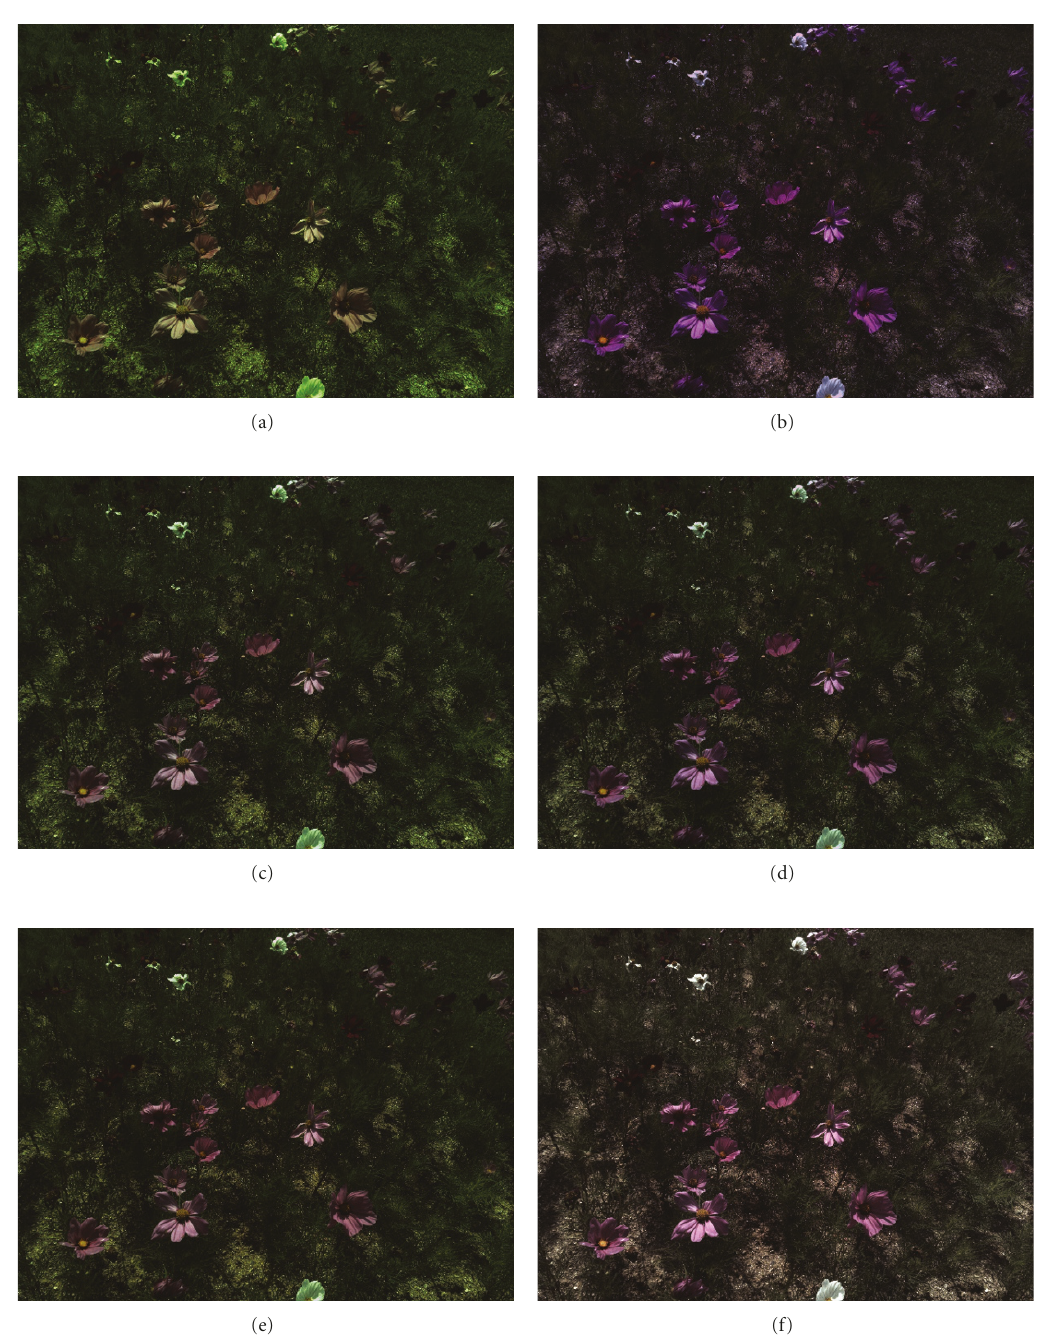
Figure 16: Result of the AWB method: (a) original image, (b) Gray world, (c) Max- RGB , (d) Shades of Gray, (e) Gray Edge, and (f) Proposed